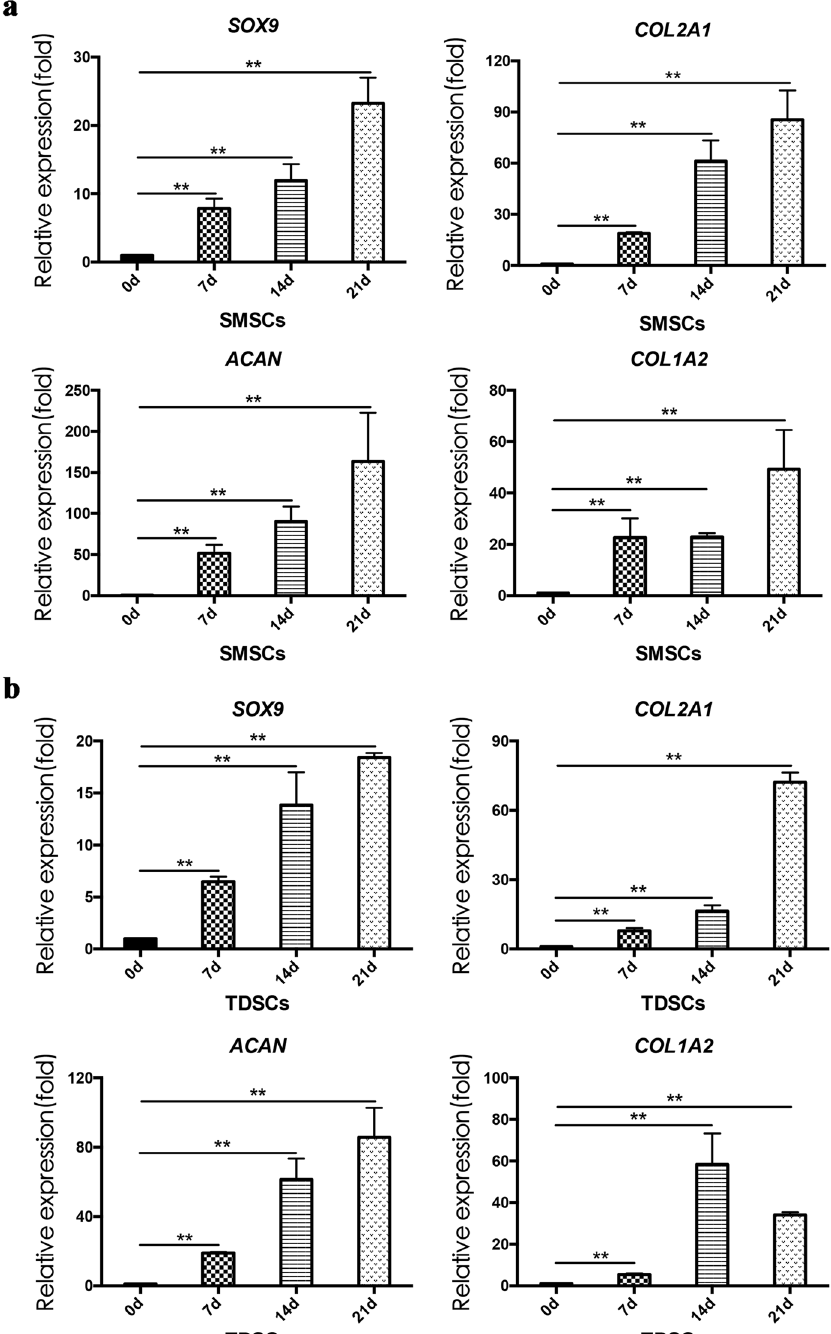
Figure 3. The expression of fibrochondrocyte-specific genes SOX9, COL2A1, ACAN and COL1A2 of SMSCs and TDSCs in DSTs in vitro . ( a ) SMSCs. ( b ) TDSCs. (n = 3, ** p <